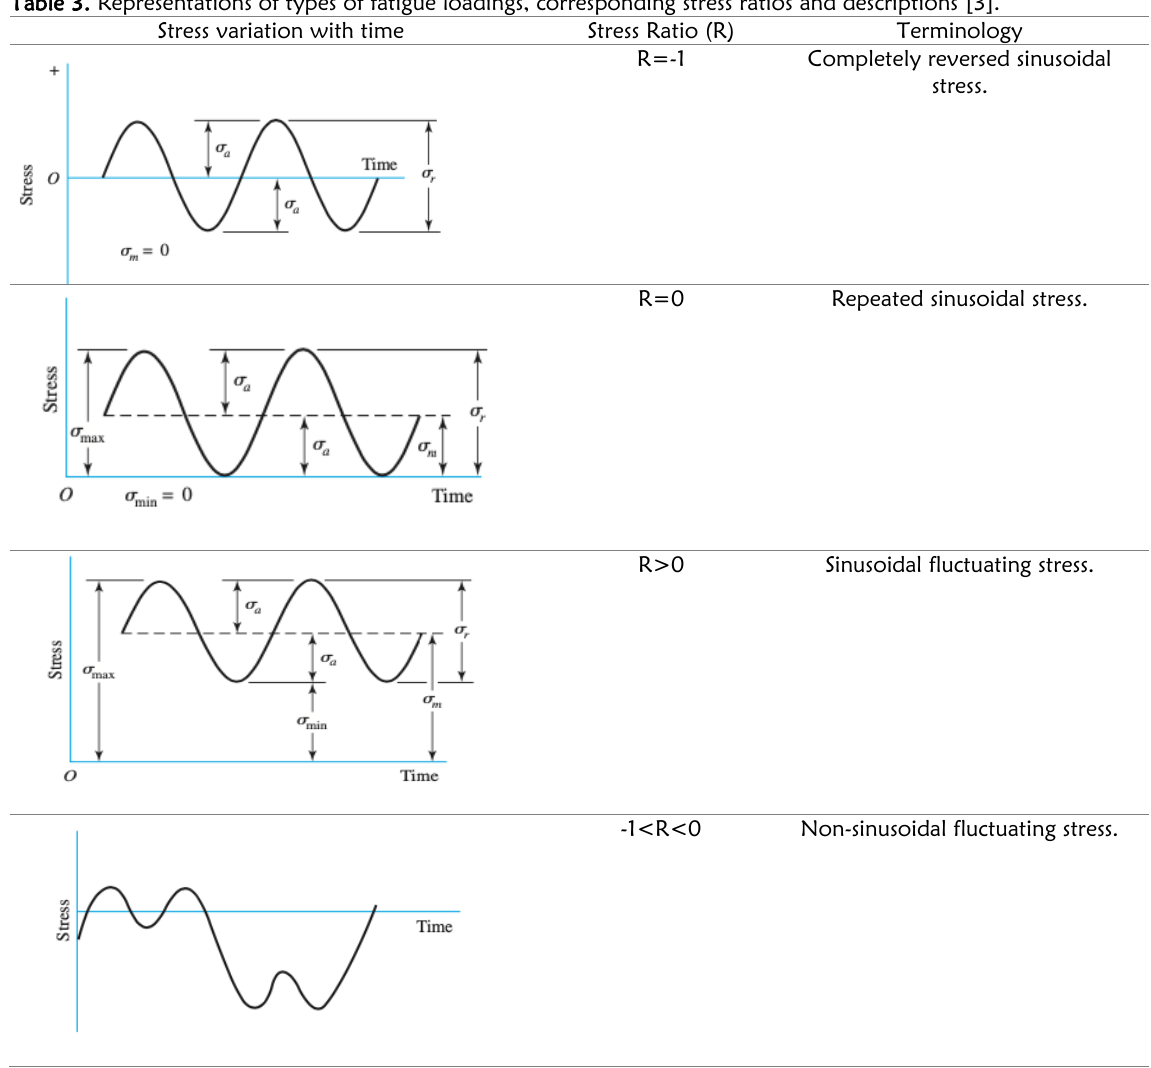
Table 3. Representations of types of fatigue loadings, corresponding stress ratios and descriptions